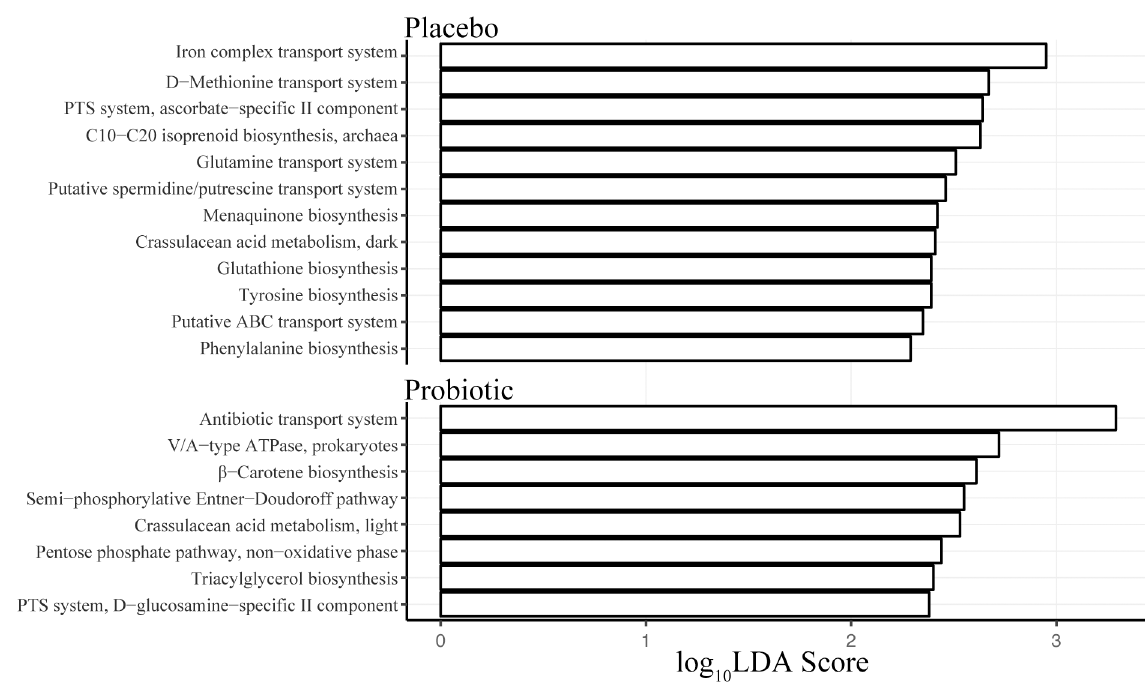
Fig 3. Predicted functional profiling of the GI microbiome in placebo or probiotic treated subjects undergoing CDI. Profiling of KEGG modules was based on 16S rRNA marker gene sequences from week 4 using PICRUSt. The α parameter for pairwise tests was set to 0.05 for class normality and the threshold on the logarithmic score of LDA analysis was set to 2.0. Modules that differed significantly in abundance between the treatment groups are displayed with the respective LDA score.